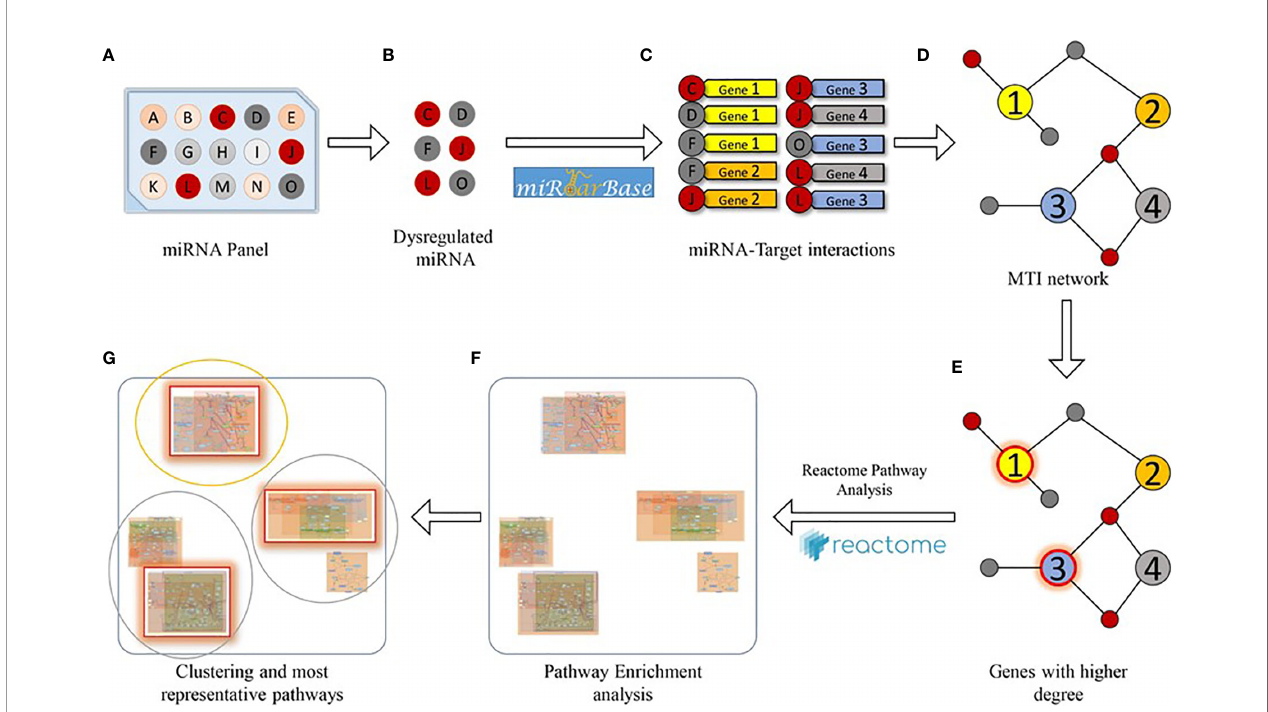
FIGURE 2 | Bioinformatics work fl ow designed for the pathway enrichment analysis. Starting from a miRNA panel (A) , dysregulated miRNAs (B) are taken into account for obtaining a list of validated miRNA-target pairs (C) from the miRTarBase database. Then, the miRNA-target interactions are arranged as a network (D) , and genes that are targeted by at least a signi fi cant number of miRNAs (E) are selected for pathway enrichment analysis (F) . Finally, enriched pathways are clustered according to their hierarchical relationships (as de fi ned in the Reactome database), and the most representative pathways (G) are